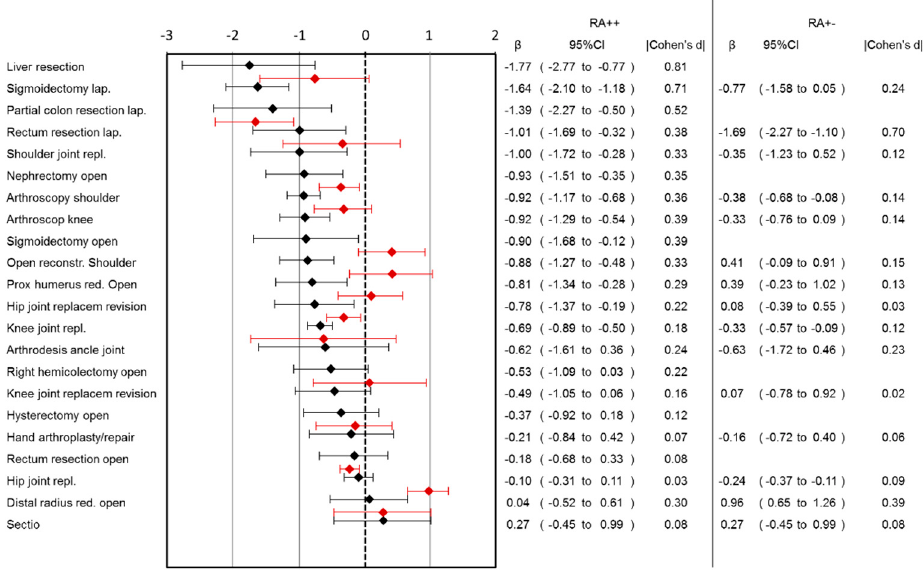
Figure 1. Association of RA with pain intensity in different surgical categories. Patients with continuous (RA++; black lines) or single-shot RA (RA+ − ; red lines) are compared to patients without RA (RA −− ). Pain was measured on an 11-step numeric rating scale (NRS). Effect sizes ( β ) and corresponding 95% confidence intervals and absolute effect sizes (|Cohen’s d|) for both analyses are shown.